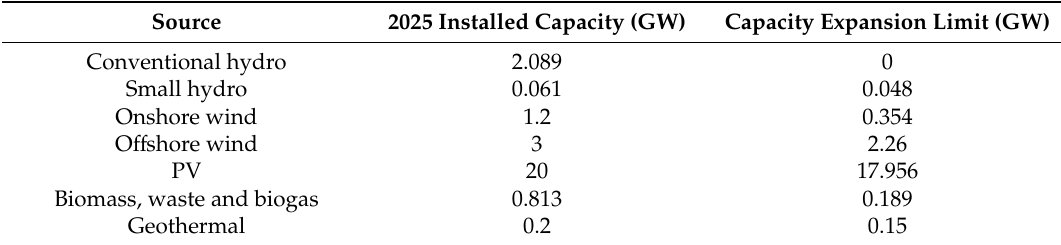
Table 5. Government targets for renewables.